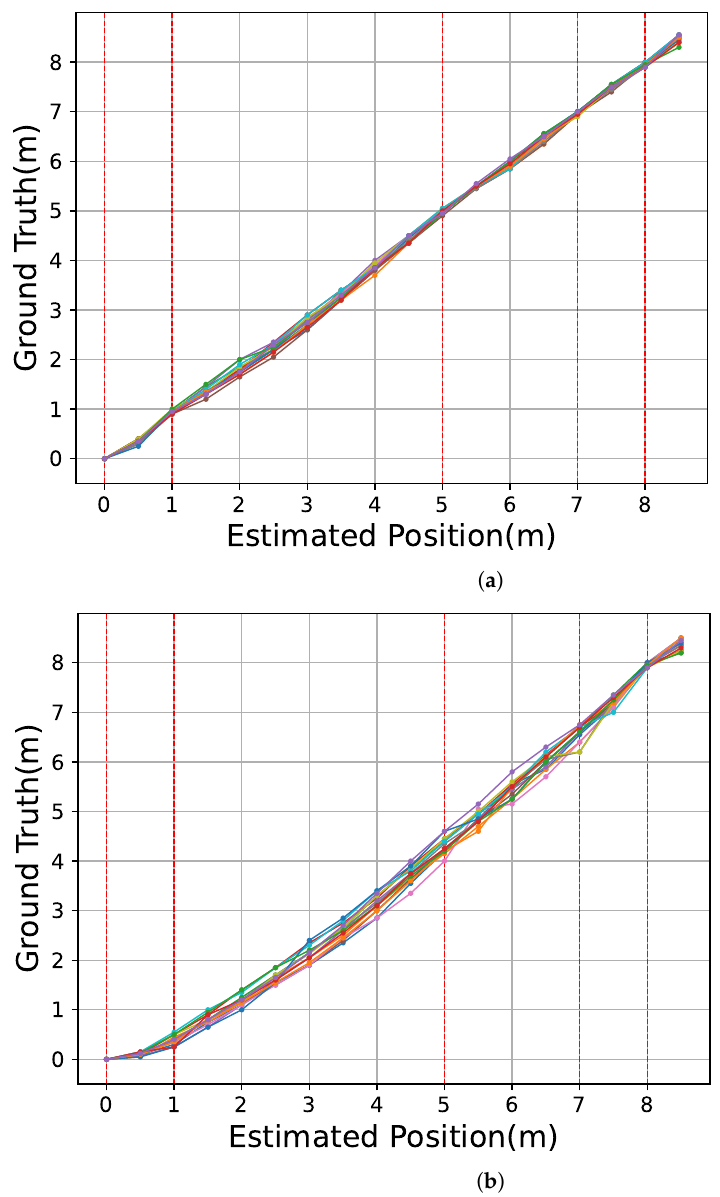
Figure 12. Relationship between the ground truth and the estimated captured position of the video frame under the linear interpolation. Each color corresponds to each of the 15 trials. ( a ) Landmarks at 0 m, 1 m, 5 m, 7 m, and 8 m are used; ( b ) Landmarks at 0 m and 8 m are